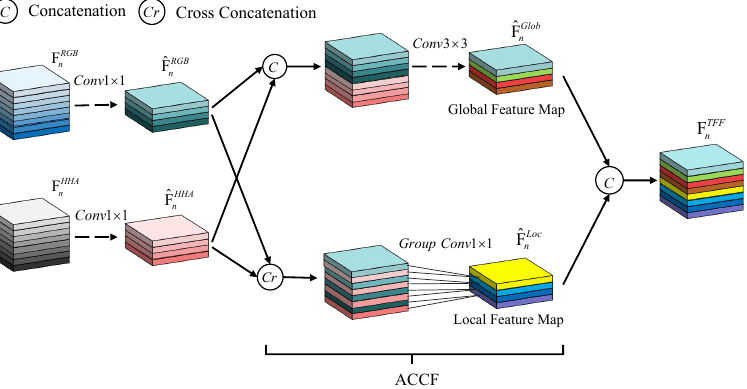
Figure 8. The detail of the proposed TFFEM. It contains two branches: (1) concatenating two modalities and learning the global channel features, and (2) learning local channel features by the ACCF block proposed in this